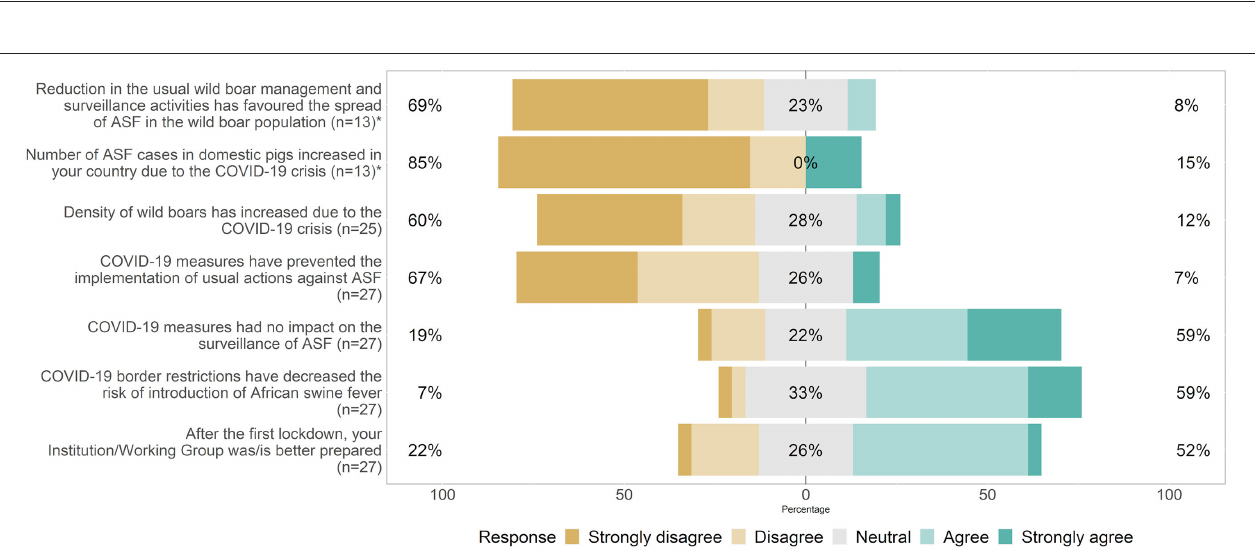
FIGURE 6 | Respondents’ ( n = 27) perception of the impact of the COVID-19 crisis on ASF surveillance and control activities and further spread in their countries (the two items at the top of the figure, marked with an asterisk, targeted respondents whose country reported ASF cases before March 2020).